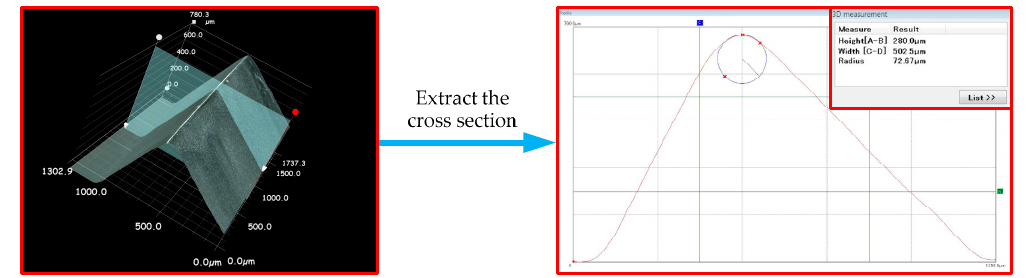
Figure 3. Measurement of cutting edge radius R max .